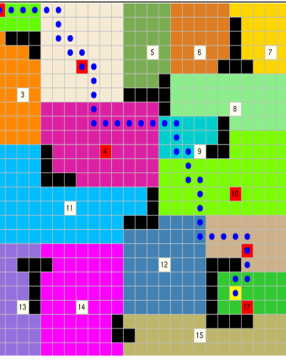
Figure 15. A path planned according to people’s preferences